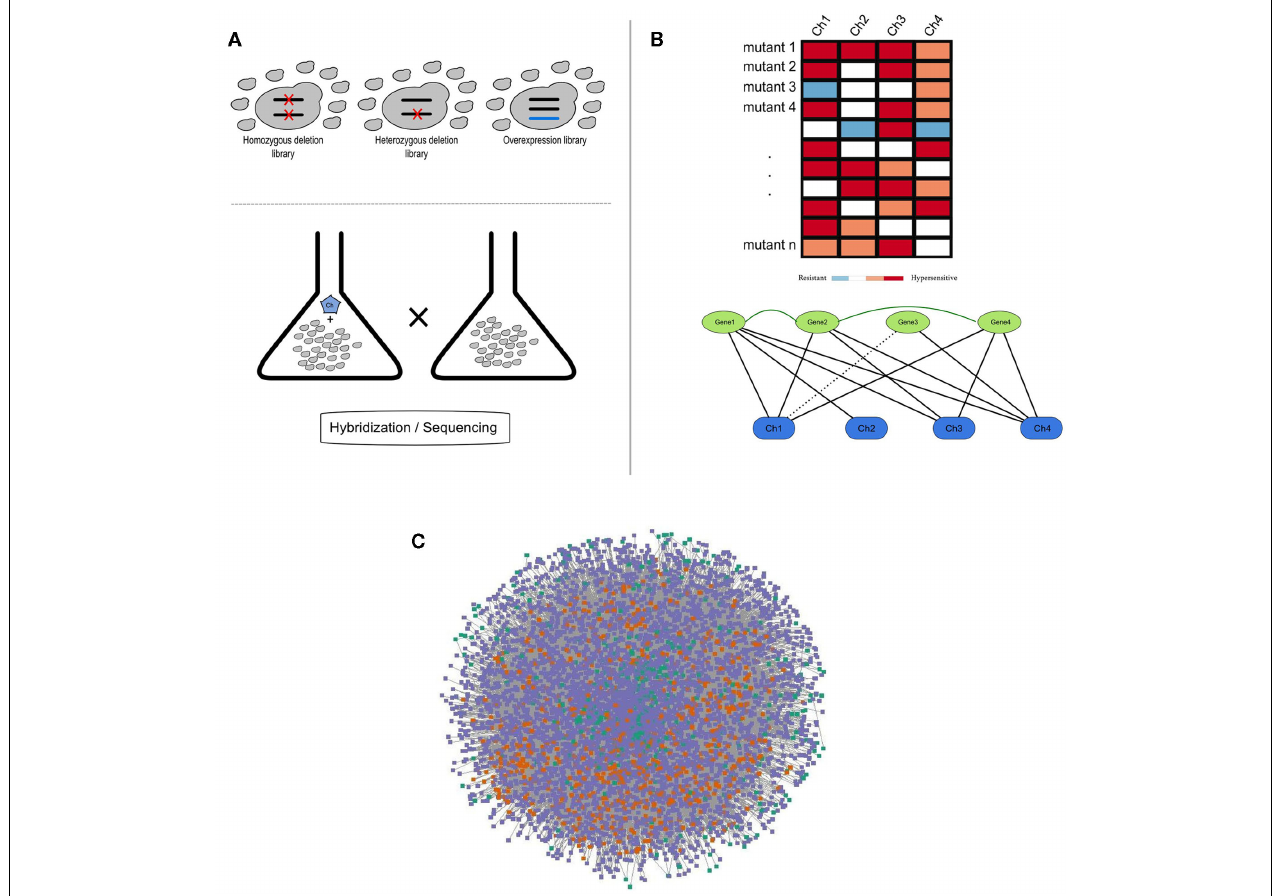
with similar chemical genetic profiles are subsequently linked (dark-green edges).This rationale was used to construct the SCPnet. Only interactions reflecting increased susceptibility were used; (C) Network representation of 34 integrated chemogenomic datasets (i.e., CPnet;Venancio et al., 2010b). Color codes: SCP-hubs (orange), chemicals (green), and other genes (purple). See the text for details on the SCP-hubs